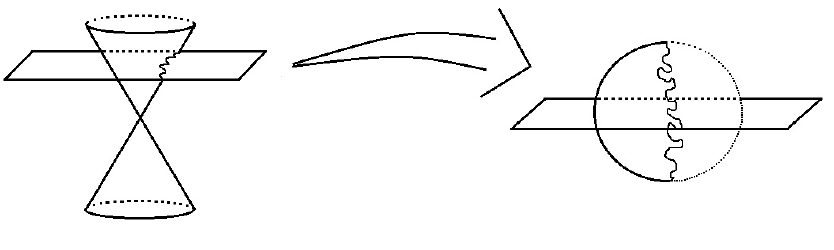
Figure 3. Pictorial effect of the black hole in the spinor